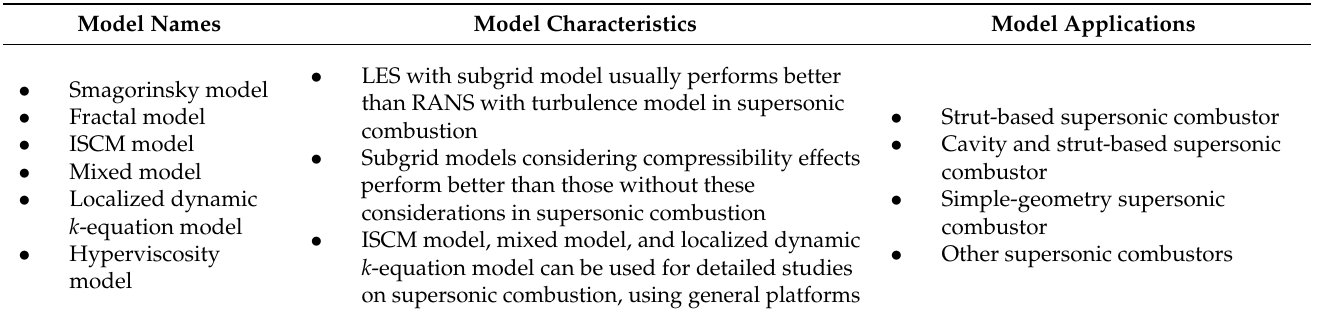
Table 1. Subgrid models commonly used for supersonic combustion on general platforms. Model Names Model